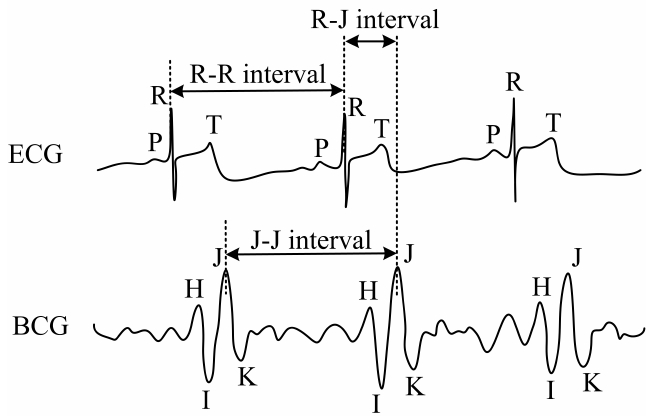
Figure 2. Sample recordings of electrocardiogram (ECG) and ballistocardiography (BCG)